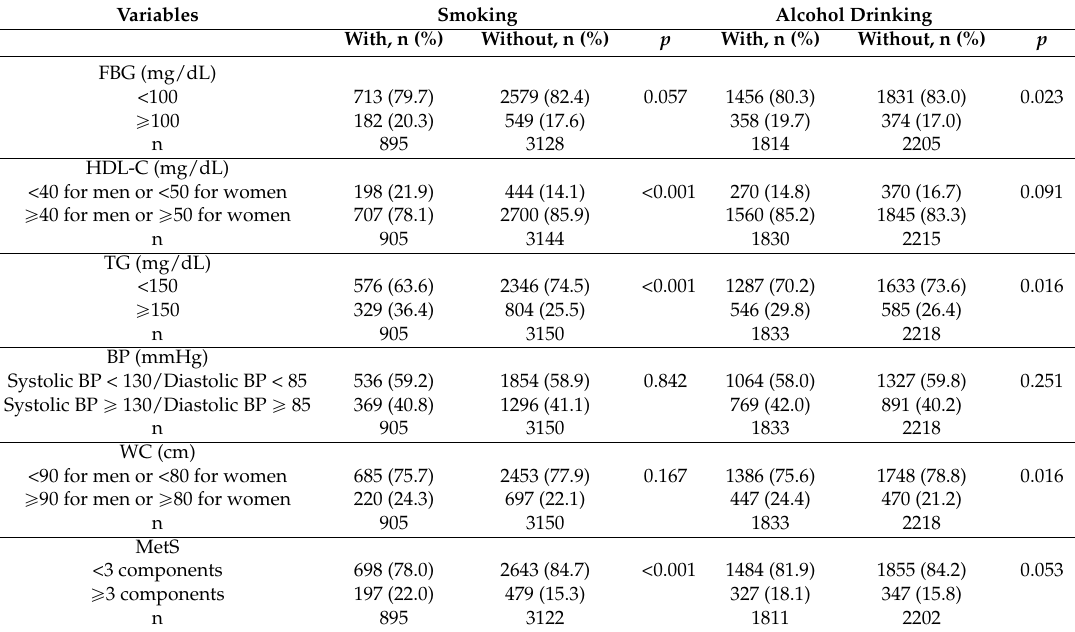
Table 2. Comparing metabolic parameters by smoking and alcohol